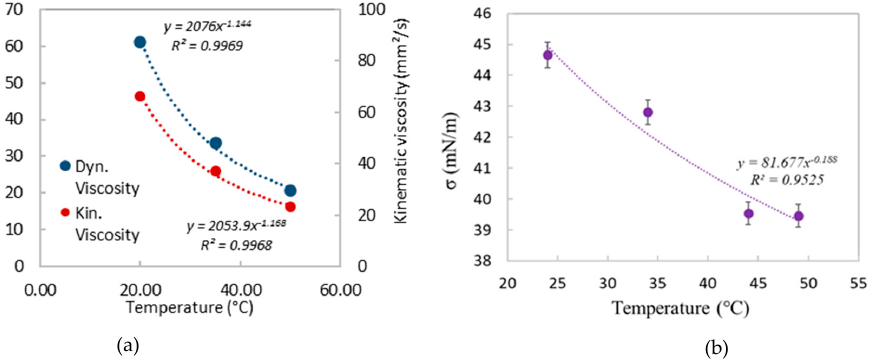
Figure 2. Temperature dependencies of kinematic and dynamic viscosity ( a ) and surface tension coefficient ( b ) of sunflower oil.